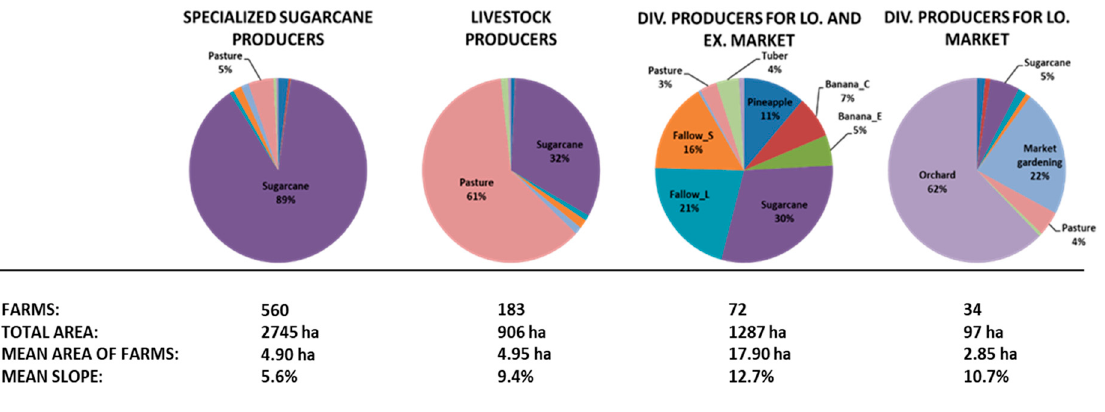
Figure 4. Typology of the farming system located in the region of North Basse-Terre based on crop rotation data from the governmental declaration database AGRIGUA of 2010. The four clusters were obtained through a hierarchical ascending classification using the principal components of interest (Kaiser criteria) from a principal component analysis. Each color corresponds to a different activity, the main ones are specified in the chart. Banana_C, Banana_E, Fallow_S, Fallow_L, correspond to banana of local varieties, Cavendish banana for export market, short fallows and long fallows (> 8 months) respectively. Table 1. Results of the climate-smart assessment framework. The 19 indicators for each farm type (“specialized sugarcane producers” (SSP), “livestock producers” (LP), “diversified producers for local and export markets” (DPLE) and “diversified producers for local markets” (DPL)) were calculated as the average value of the three farms surveyed. The last column, “weighted mean”, was based on the area represented by each farm type and corresponds to the performance of the farming system. Spe. Sugarcane Livestock Indicators Unit/Year Producers N = 3 % − 42% 7% 2% 57%